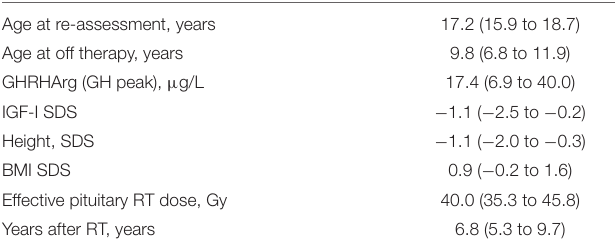
TABLE 3 | Clinical characteristics and GH responses to GHRHarg in 29 patients with effective RT pituitary